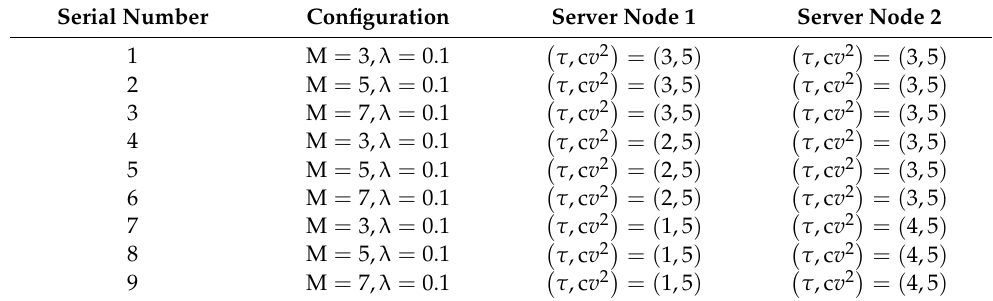
Table 7. Model comparison environment.